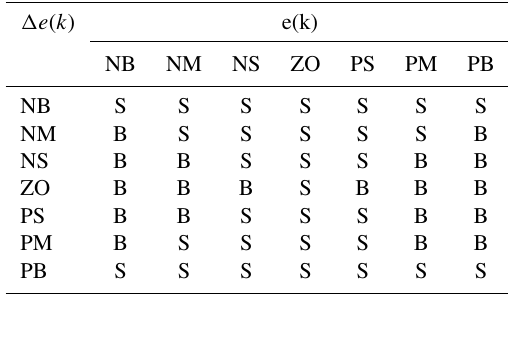
Table 4. Parameters of